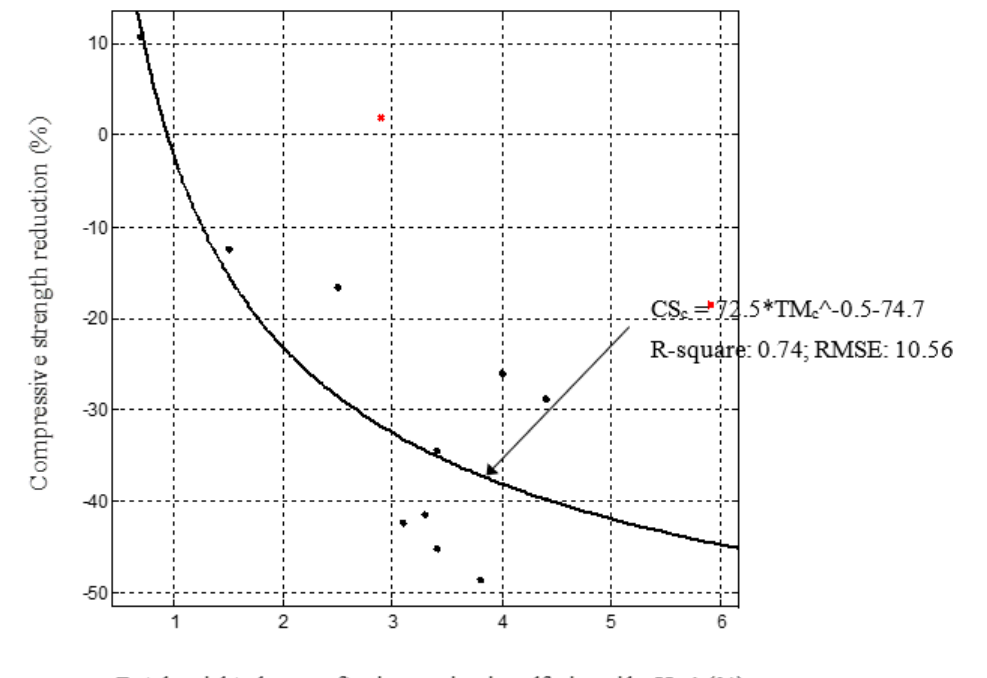
Figure 11. Compressive strength change against total mass change after immersion in sulphuric acid.